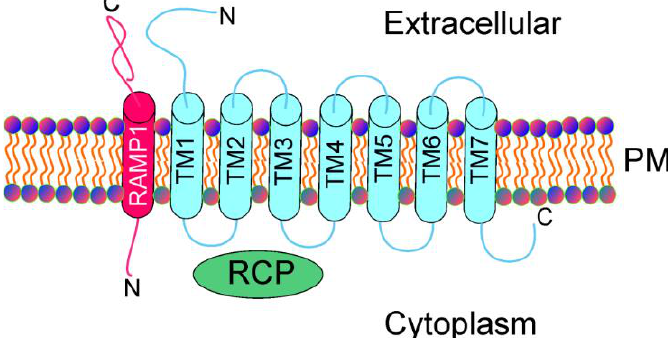
Figure 2. Calcitonin gene-related peptide receptor, a complex heterotrimeric G-protein-coupled receptor, consists of the calcitonin-like receptor (CLR), receptor activity-modifying protein 1 (RAMP1), and a small receptor component protein (RCP). CLR includes 7 transmembrane proteins (TM1–7), whereas RAMP1 is a single transmembrane protein. PM—plasma membrane.